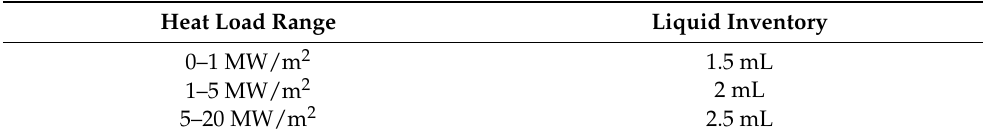
Table 2. The heat load ranges with their corresponding liquid inventories.